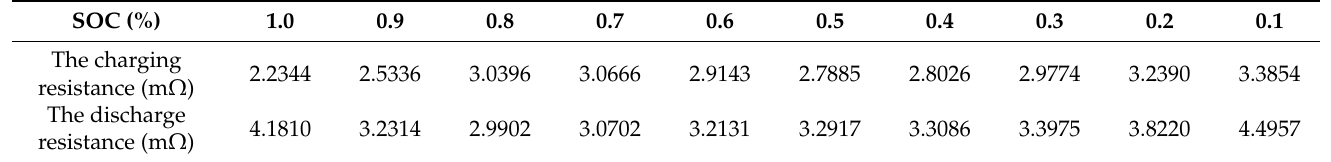
Table 1. Measurement results of battery internal resistance.